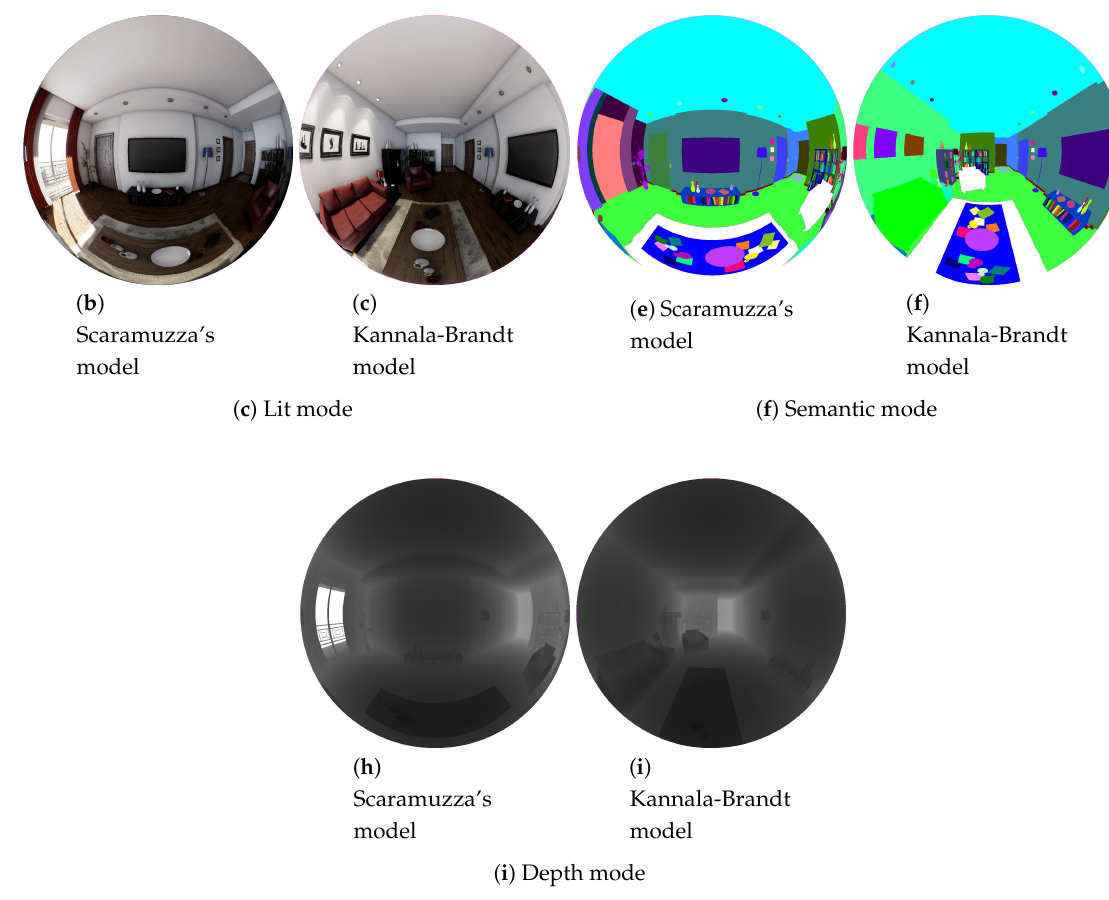
Figure A10. Scaramuzza and Kannala-Brandt empiric